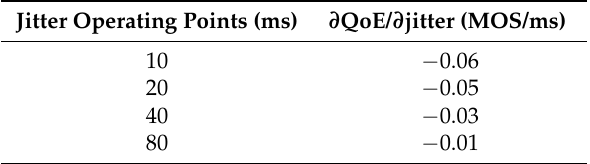
Table 3. First derivative of QoE w.r.t jitter at operating points.